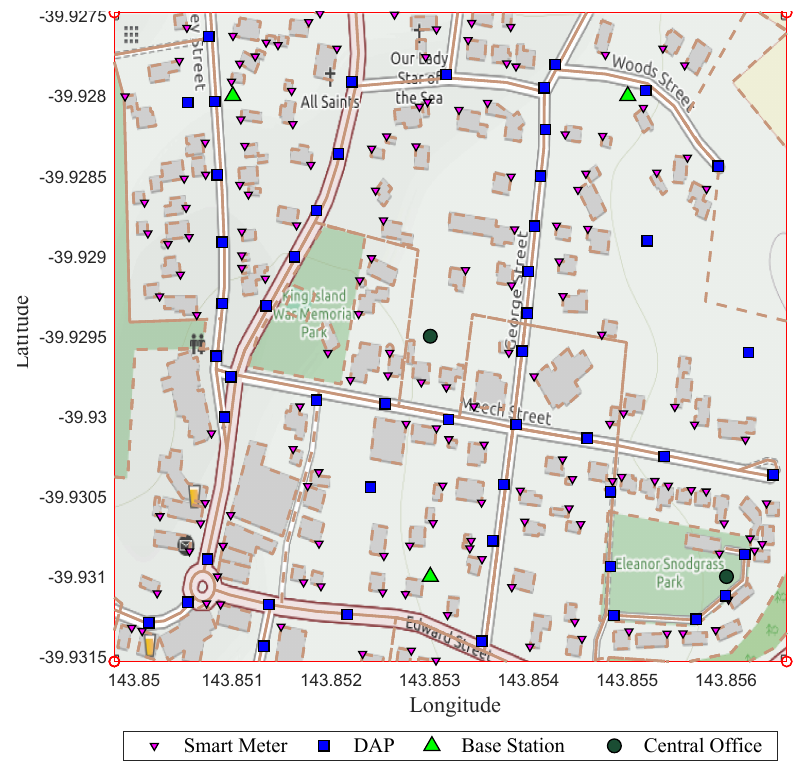
Figure 2. Geo-referenced case study and its infrastructure elements.